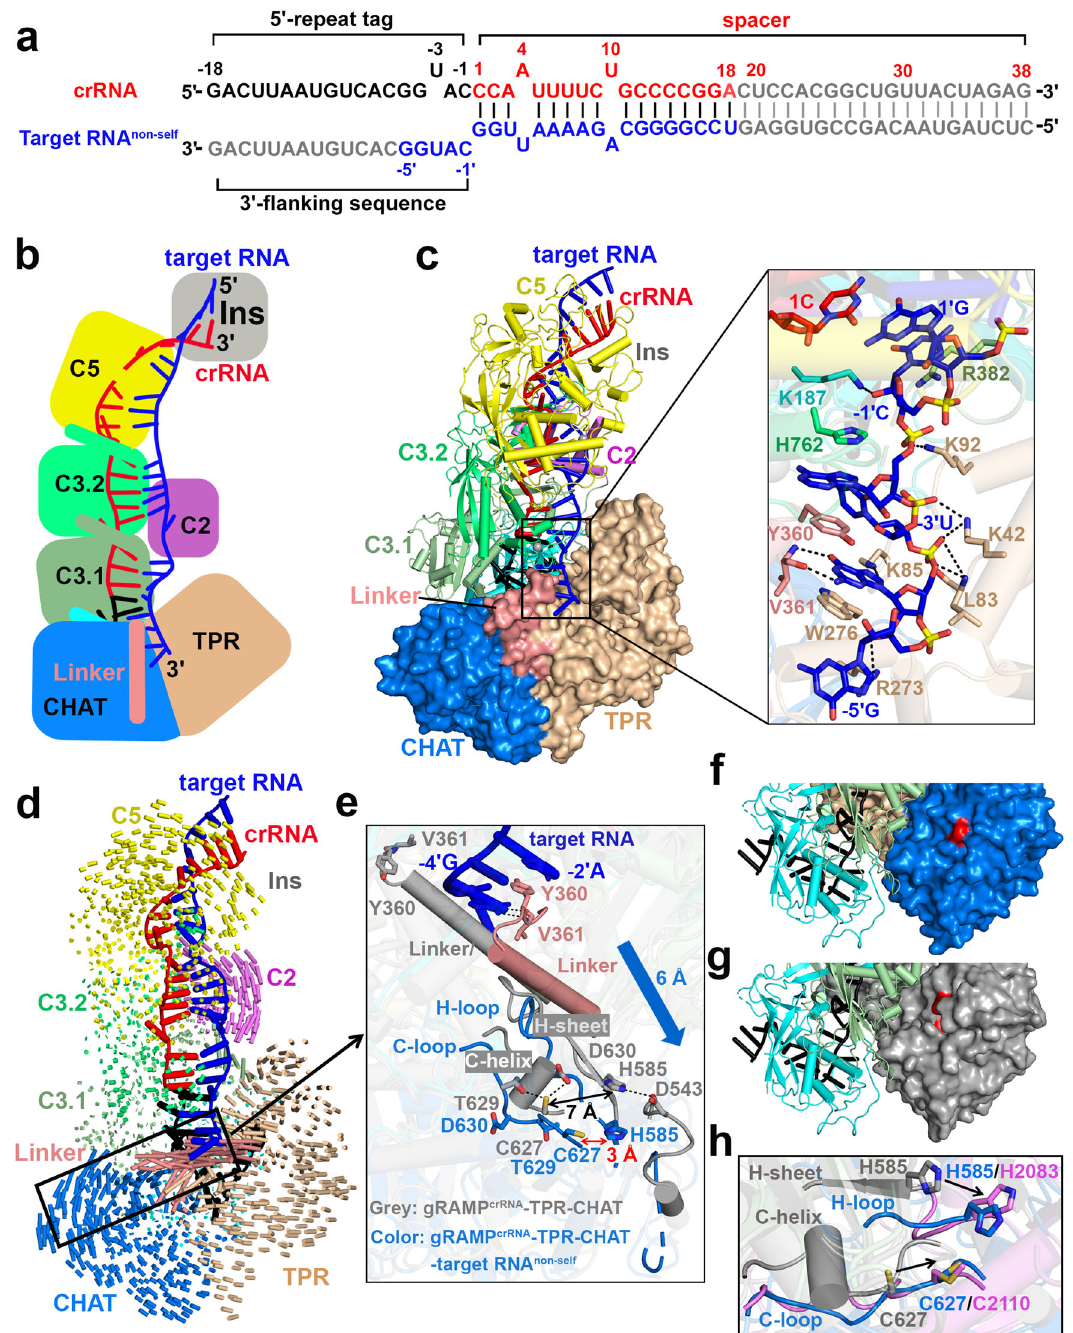
Fig. 4 | Binding of invasive non-self RNA target induces large conformational changes of gRAMP crRNA -TPR-CHAT complex. a Schematic drawing for the sequences of crRNA and non-self RNA target. Segments that can be traced are in color, while disordered segments are in gray. Schematic ( b ) and ribbon ( c ) repre- sentations of cryo-EM structure of gRAMP crRNA -TPR-CHAT complex bound to non- self RNA target. TPR-CHAT protein is shown in a surface view. The expanded view showsthedetailedinteractionsbetween3 ′ - fl ankingsequenceandproteinresidues ingRAMPandTPR-CHAT. d StructuralcomparisonbetweengRAMP crRNA -TPR-CHAT complex before and after binding to non-self RNA target. Vector length correlates with the domain movement scale. e Detailed conformational changes induced by